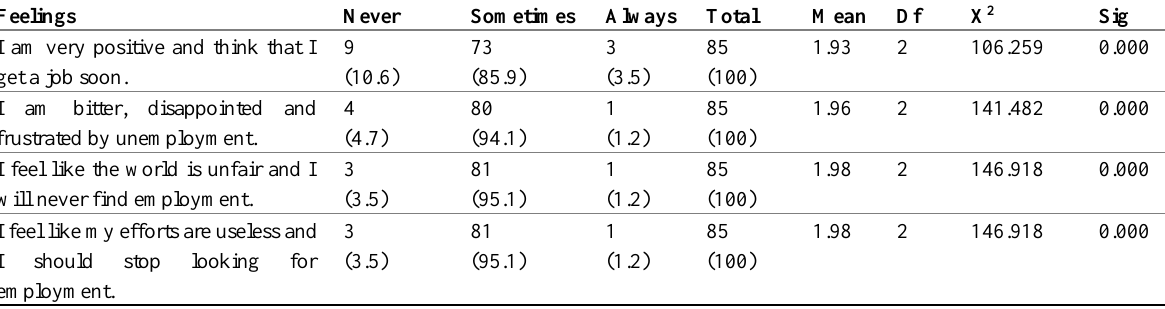
Table 2: Feelings of the unemployed